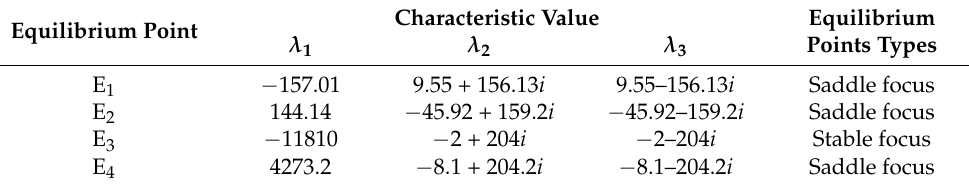
Table 3. Characteristic roots of the Jacobian matrix J .